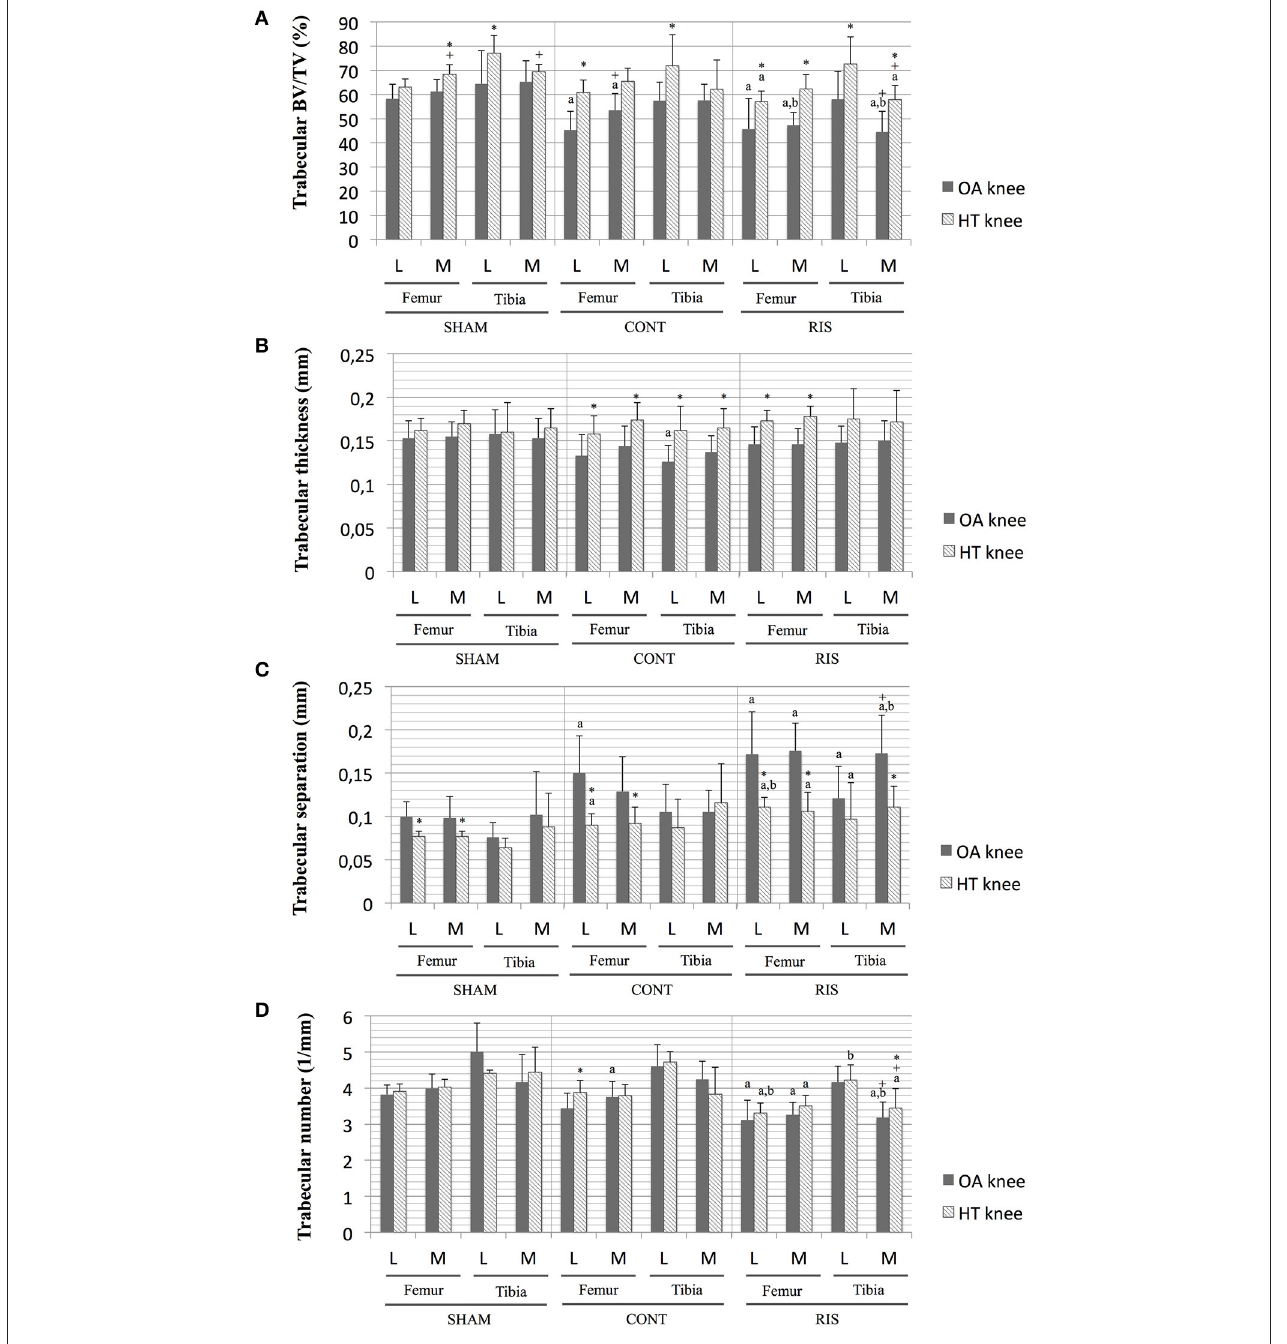
FIGURE 5 | Micro-CT trabecular analysis on central VOI of osteoarthritic and healthy joints. (A) BV/TV, bone volumetric fraction; (B) Tb.Th, trabecular thickness; (C) Tb:Sp, trabecular separation; (D) Tb:N, trabecular number. Values given as mean ± SD. Statistical significant differences p < 0.05: a vs. SHAM, b vs. CONT, + vs. lateral compartment, *vs. OA